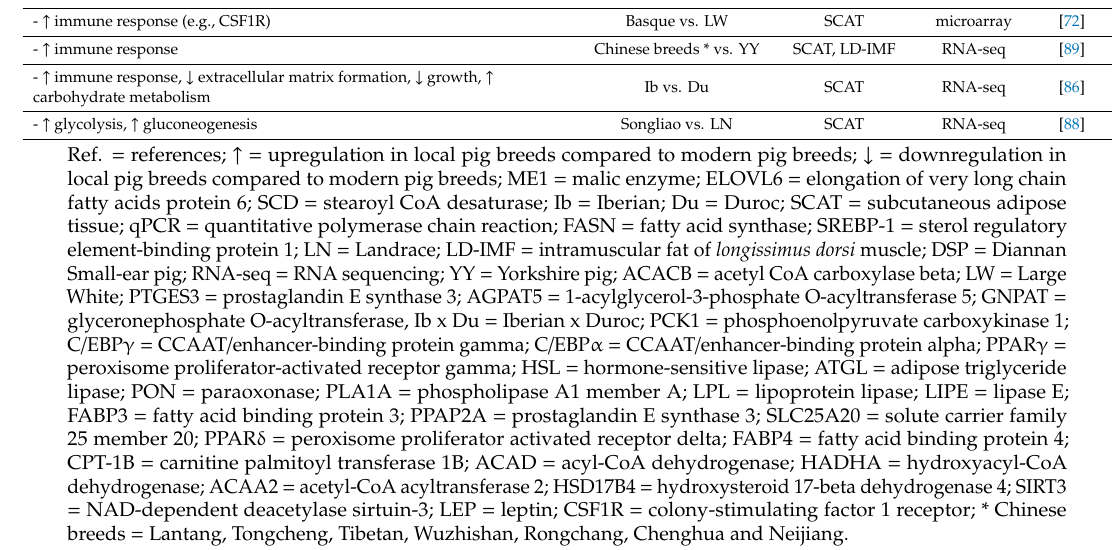
Basque vs. LW Wujin vs. LN Min vs. LN Chinese breeds * vs. YY SCAT, LD-IMF Basque vs. LW DSP and Tibetan vs. LN and YY LD-IMF RNA-seq Ib vs. Du Ib vs. Du SCAT RNA-seq Songliao vs. LN SCAT RNA-seq Basque vs. LW Chinese breeds * vs. YY SCAT, LD-IMF RNA-seq Ib vs. Du SCAT RNA-seq Songliao vs. LN SCAT